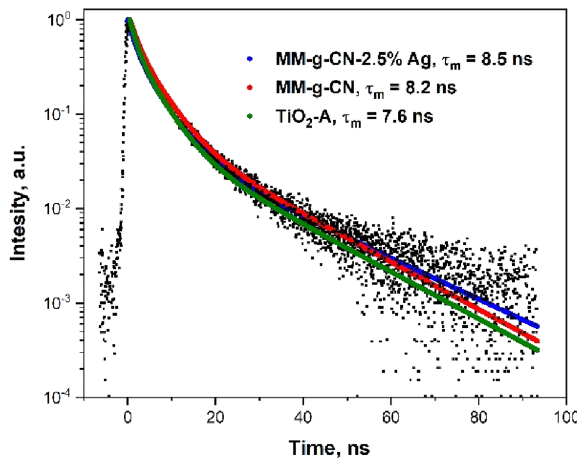
Figure 8. Normalized PL decay curves of MM-g-CN-2.5% Ag, MM-g-CN, and TiO 2